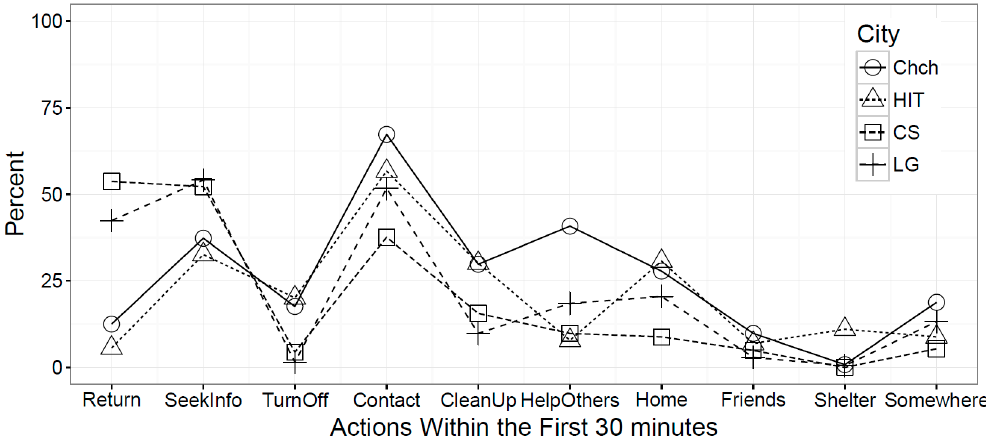
Figure 2 . Percentage of response actions within 30 minutes after shaking caused by earthquake stopped. Figure 2. Percentage of response actions within 30 min after shaking caused by earthquake